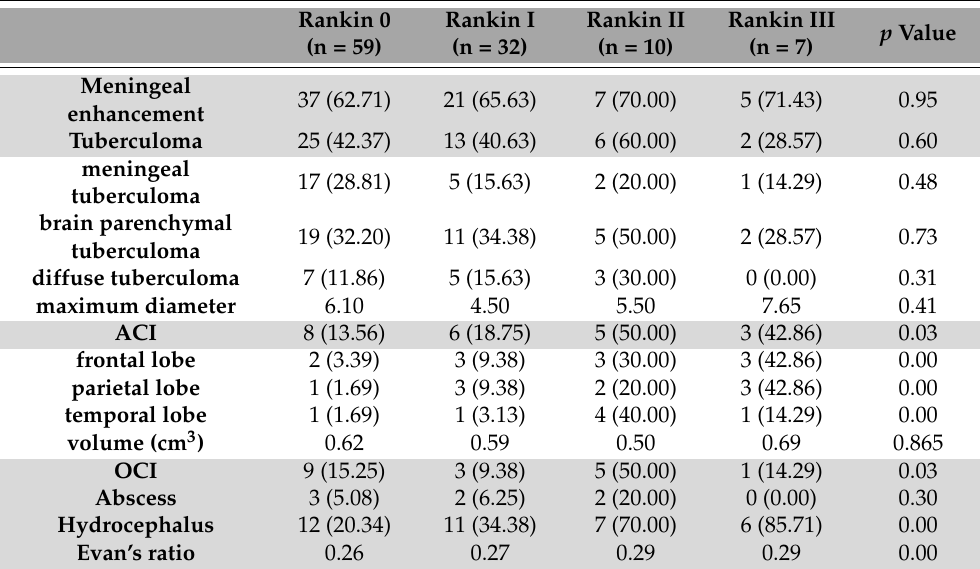
Table 4. MRI features of TBM patients with different